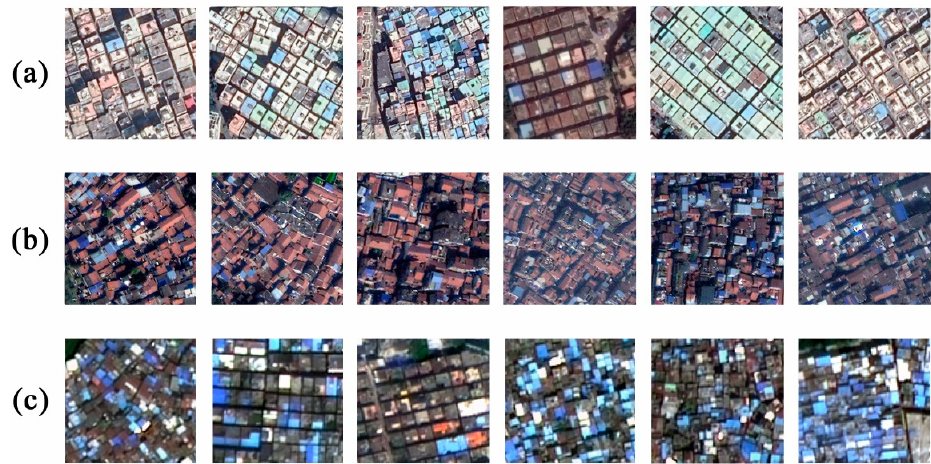
Figure 3. Urban villages in ( a ) Shenzhen, ( b ) Wuhan, and ( c ) Guangzhou (source of a and b : Google Earth).